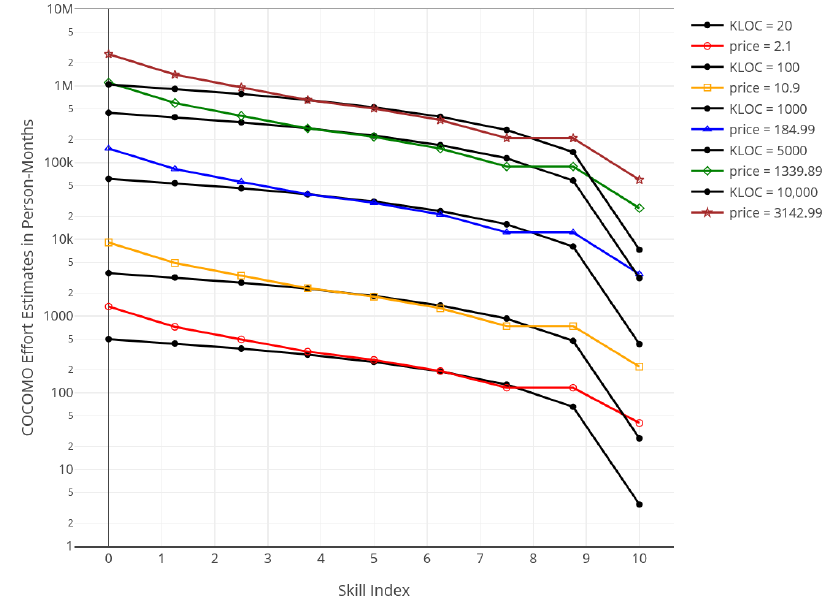
Figure 8. Statistical Agent-based Model of Development and Evaluation (SAbMDE)-to-COCOMO effort estimation comparison for various KLOC